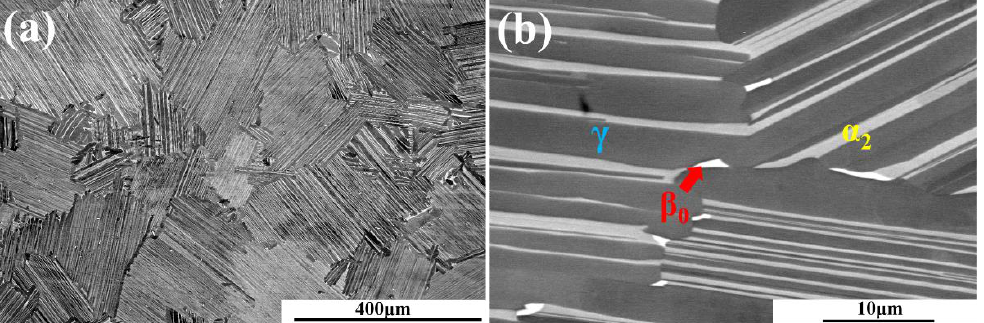
Figure 1. SEM-BSE micrographs of the microstructure of the P-HIPed TNM alloy. ( a ) Low-magnification micrograph showing the fully lamellar microstructure; ( b ) high-magnification micrograph showing the β 0 particles distributed at colony boundaries.